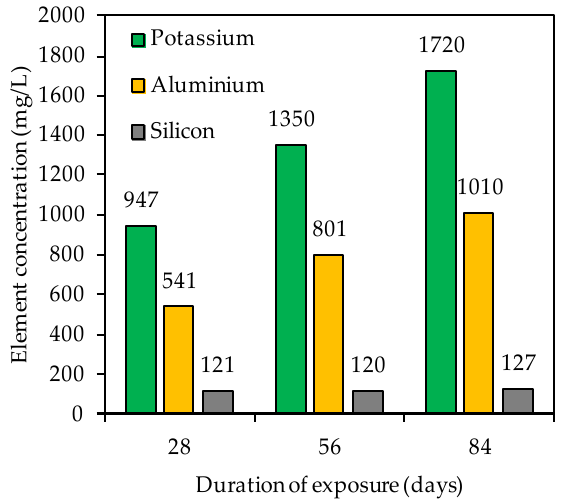
Figure 9. Potassium, silicon and aluminum concentration in sulfuric acid solution after 28, 56 and 84 days of exposure.